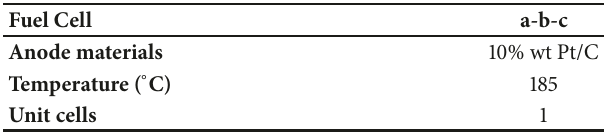
Table 5: Construction and operational parameters of fuel cells presented in Figure 7. F uel